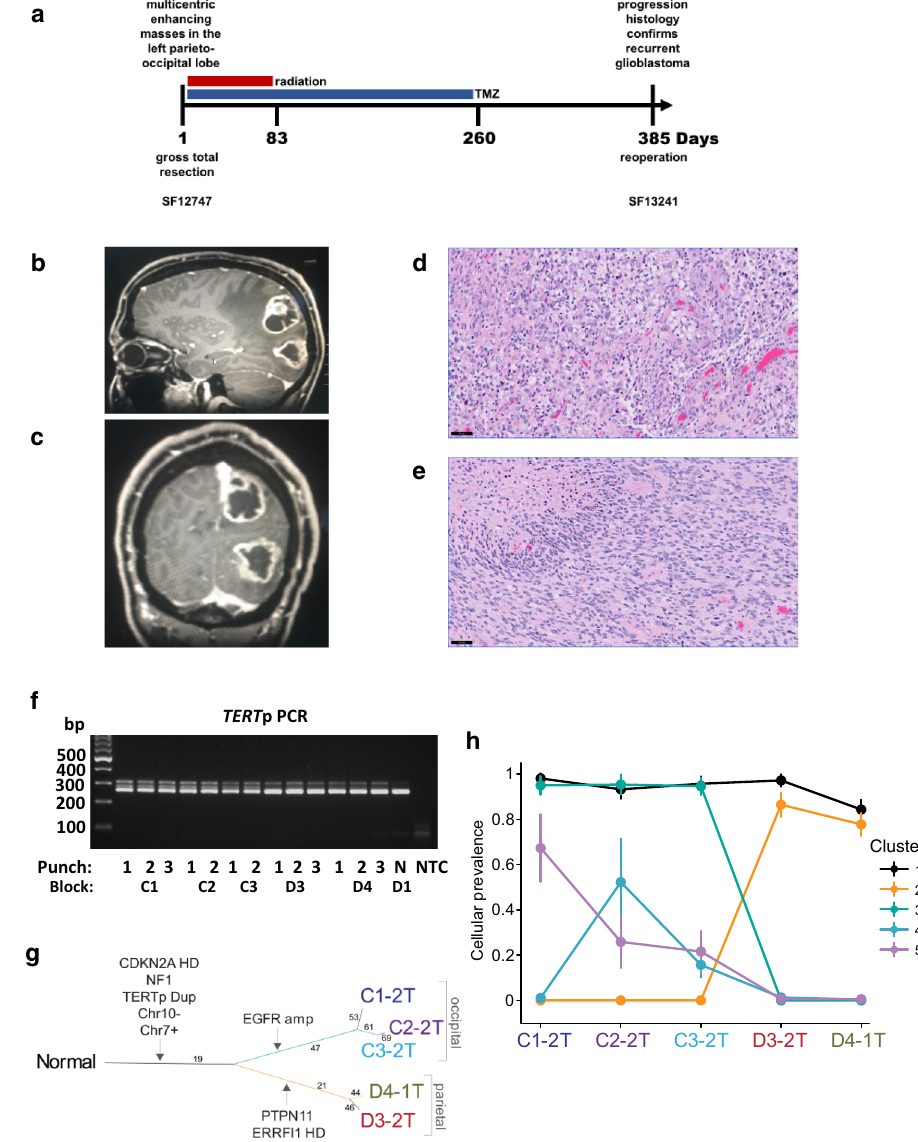
Fig. 4 | Clonal evolution of a multifocal glioblastoma with the TERT p dupli- cation. a Clinical timeline. Multiple tumor tissue samples were obtained from the IDH-wildtype and TERT p duplicated glioblastoma at diagnosis (SF12747) and one sample was obtained at recurrence (SF13241). b , c MRI of enhancing masses in the left parieto-occipital lobes with surrounding edema and mass effect. d , e H&E staining of an FFPE section from the ( d ) occipital lobe tumor focus and the ( e ) parietal lobe tumor focus. Scale bar denotes 50 µ m. f TERT p PCR spanning the native ETS motif and duplication for the DNA isolated from FFPE punches from multiple regions of the newly diagnosed tumor, and a no-template control (NTC). Lane 1 includes the DNA ladder for reference of base pair (bp) size. C# and D# indicate the block, # indicate the tumor and N the tumor-adjacent normal brain punch,respectively.Theexperimentwasperformedoncebecauseofthelimitation of patient material. g SNV-based phylogenetic tree from the exome sequencing of